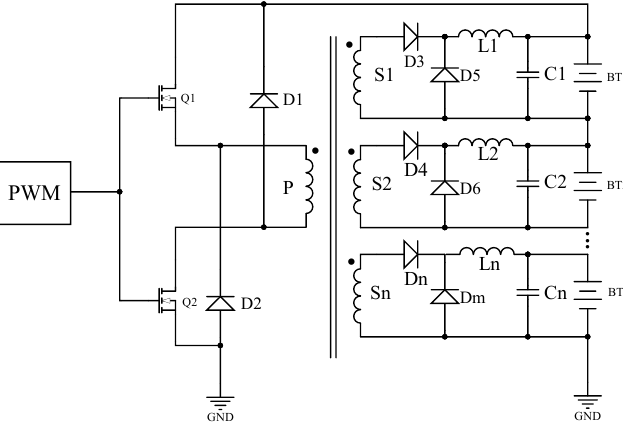
Figure 2. Schematic of a two-switch forward converter